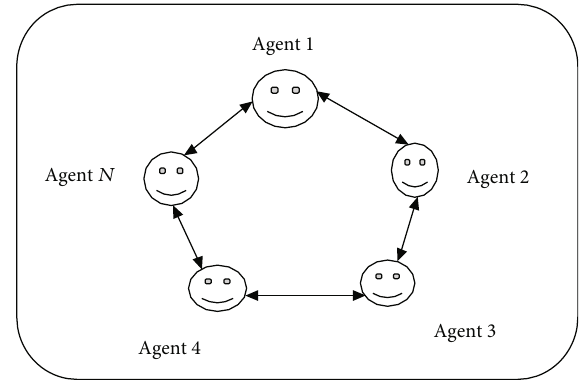
Figure 1: A multiagent system used for resolving interoperability issues. Here agent container contains agent 1: resolve precision value issue; agent 2: resolve array with null value